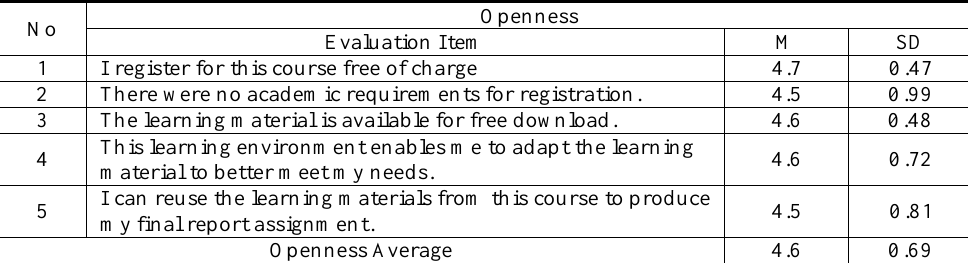
Descriptive Results of Openness